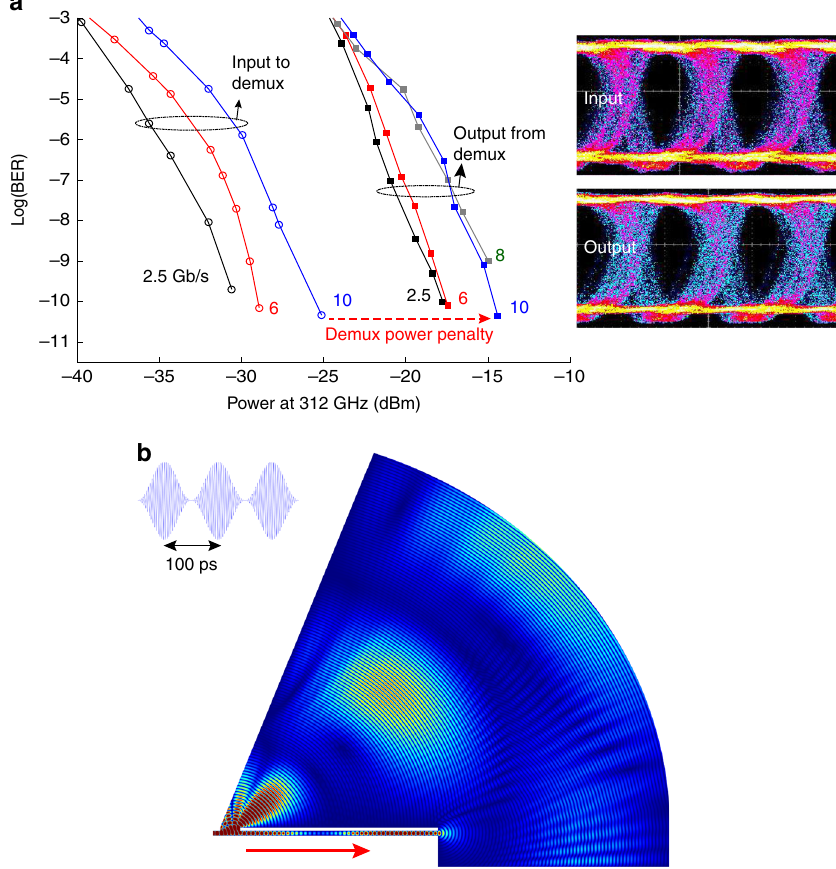
Fig. 2 Demultiplexing of modulated THz channels as a function of detected power. a Measured real-time BER performance of the THz link as a function of the THz power at the receiver under different data rates up to 10 Gb/s. Values are recorded both before the demultiplexer ( left set of curves ), and also after demultiplexing ( right set of curves ) with the detector fi xed at the optimum angular position for the carrier frequency of 312 GHz. Data rates are shown next to each curve , in Gb/s. Typical eye diagrams are shown for the input and demultiplexed links at a data rate of 10 Gb/s, both showing error-free transmission ( BER < 10 − 10 ). Before demultiplexing, all the curves have about the same slope. But after the device, the slope changes for the higher data rates (8 and 10 Gb/s), due to scattering of residual radiation at the output end of the waveguide. b One frame from a two-dimensional numerical time-domain simulation movie, depicting the scattering phenomenon, which leads to inter-symbol interference at higher data rates, as discussed in the text. The inset ( upper left ) shows the input waveform for the simulation, which is a 300 GHz carrier wave modulated so that a pulse of radiation enters the waveguide every 100 ps. The waveguide is at the bottom left , where the red arrow indicates the propagation direction for the guided wave. Interference fringes are clearly evident due to interference between the bit emerging from the far end of the waveguide and the previous bit, which radiated through the